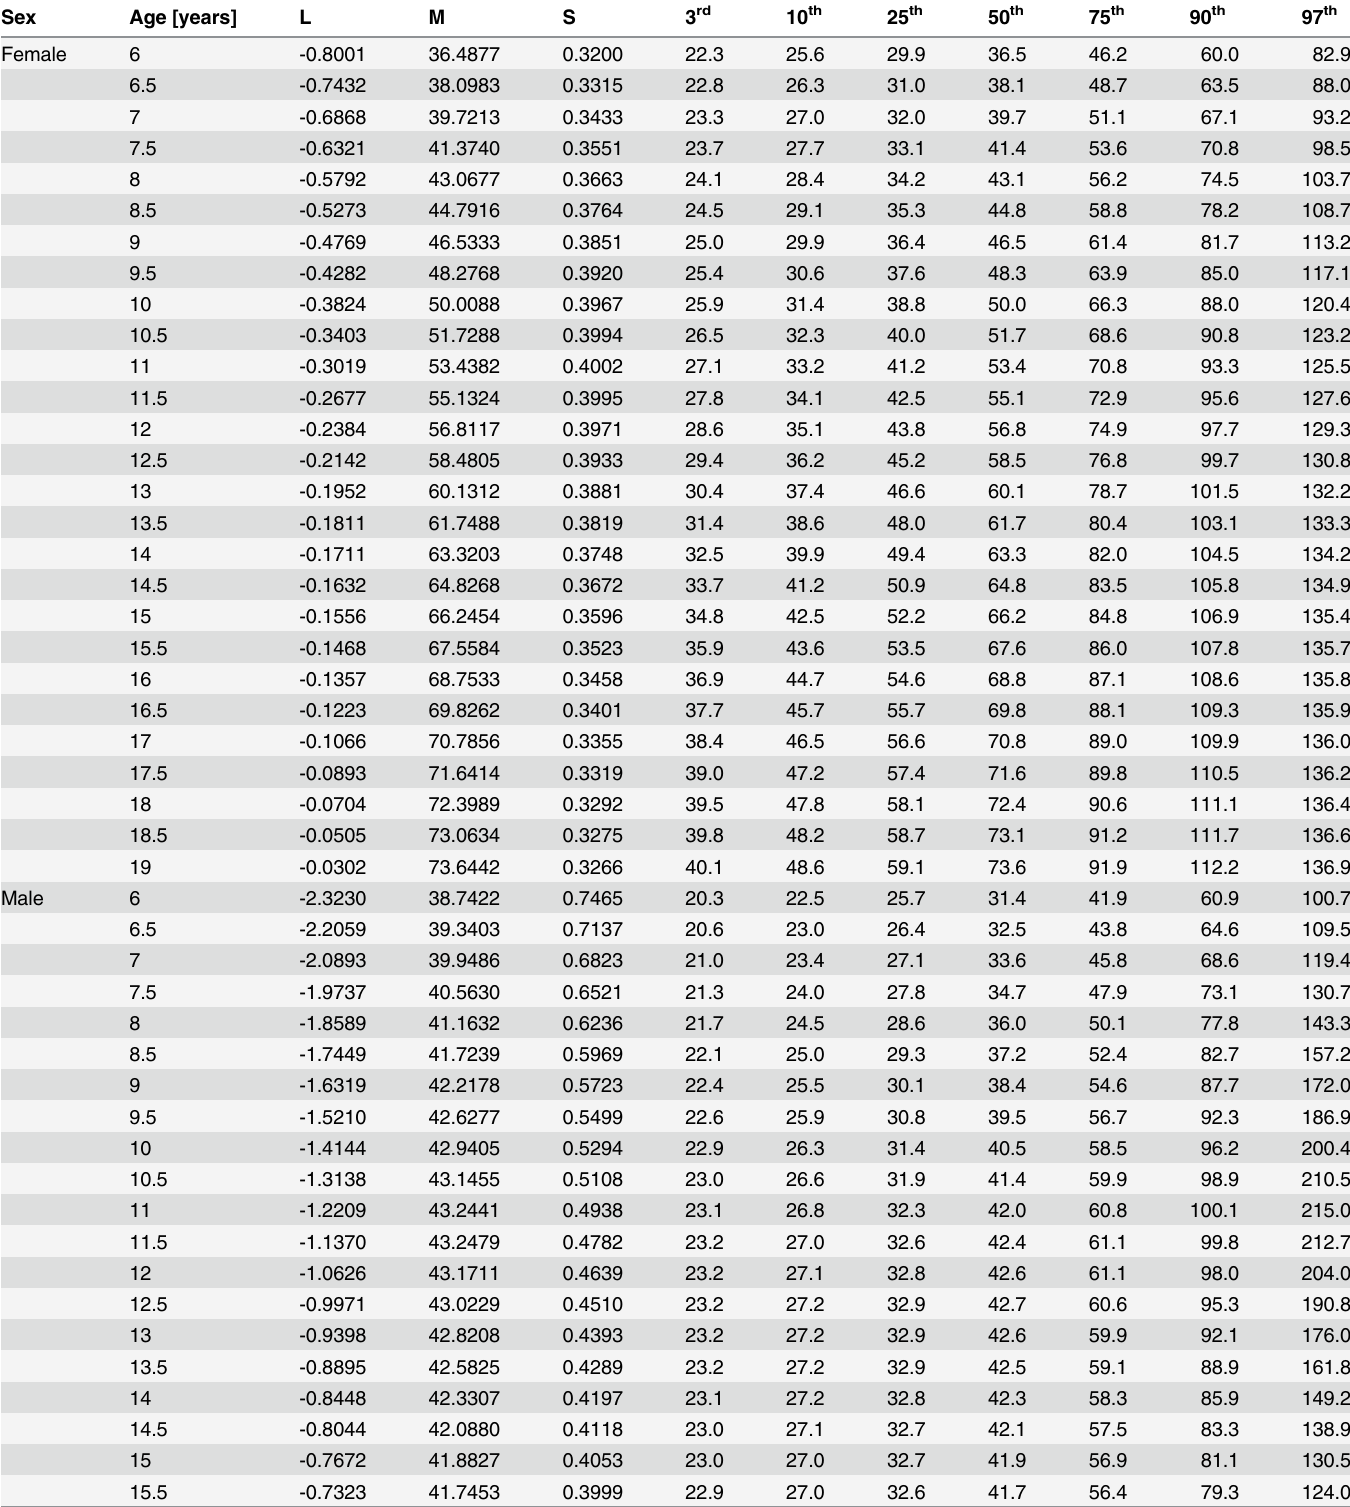
Table 5. L, M, and S values, and percentiles of sum of 5 skinfolds [mm] by age and sex for Canadian children and youth aged 6 to 19